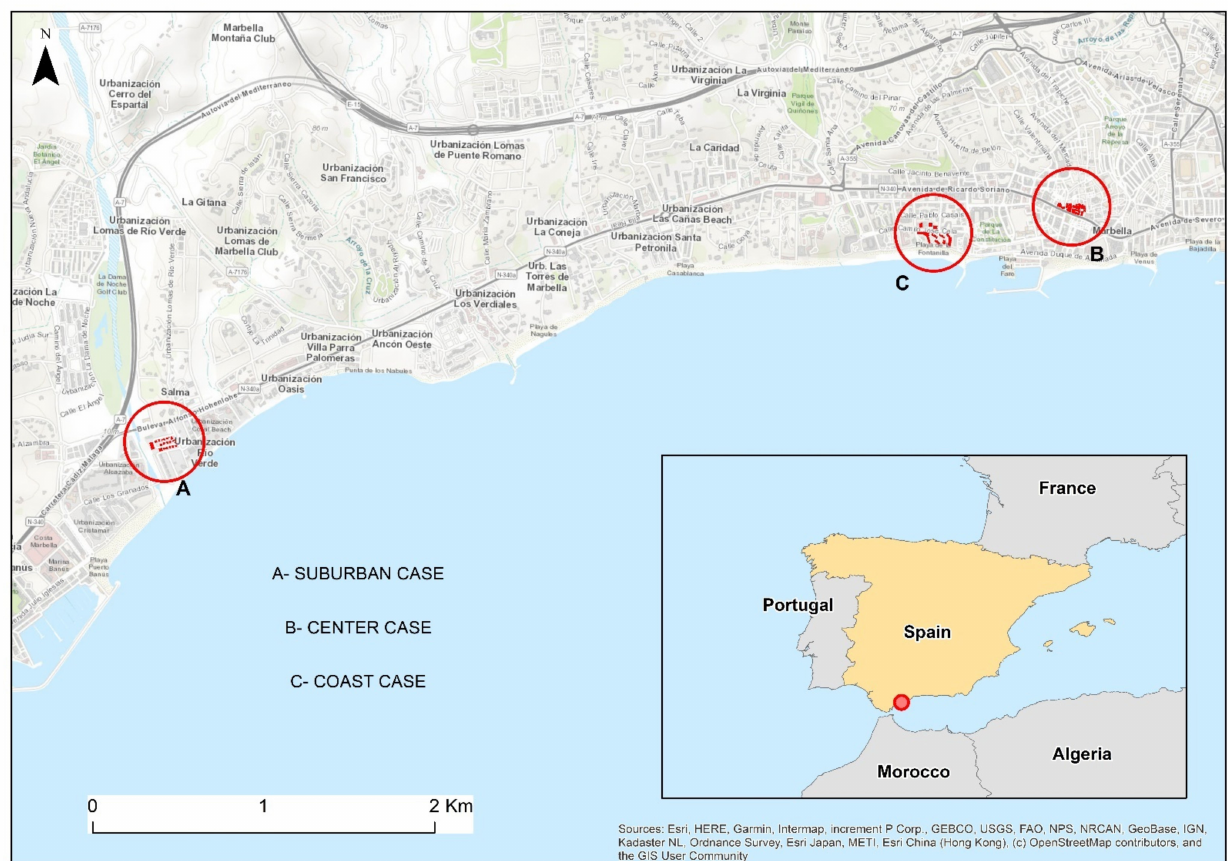
Figure 1. Location of the three areas of